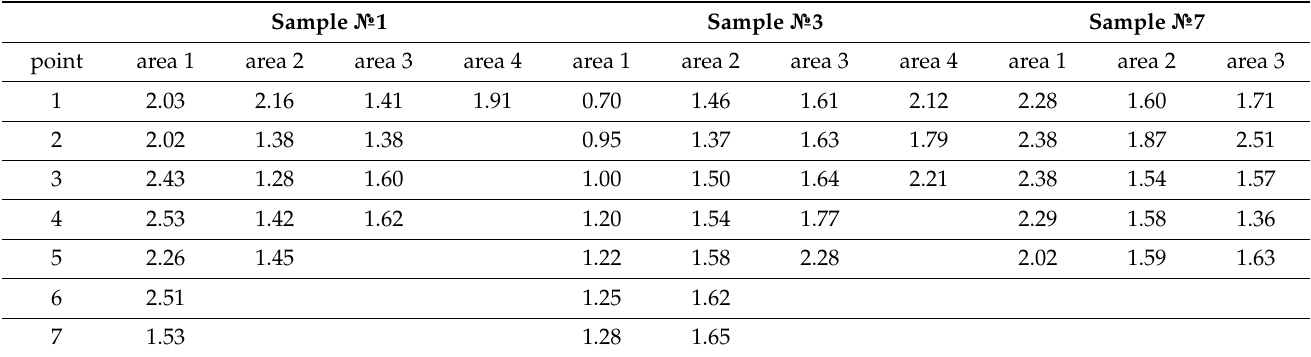
Table 2. Values of the intensity of deformation of cast iron in the studied flange zones.